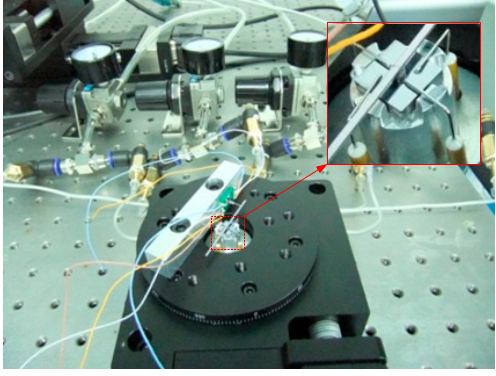
Figure 12. The measurement platform.